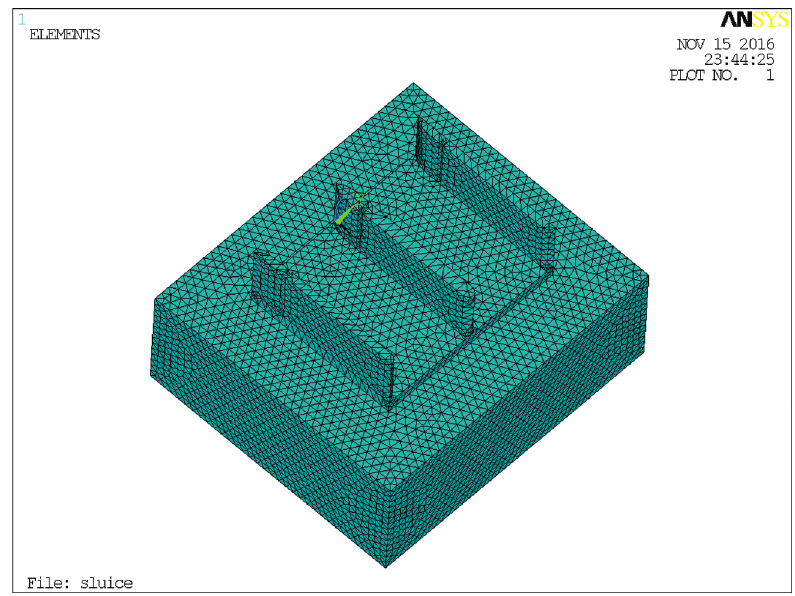
Figure 3: Lock chamber structure mesh